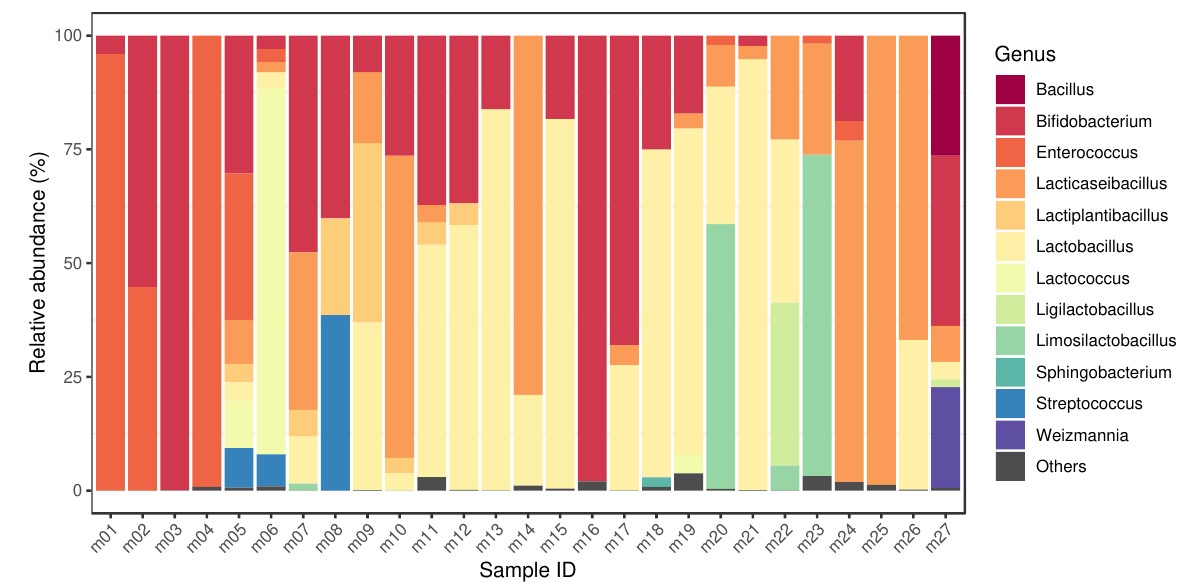
Figure 1. Bacteriome of samples. The relative abundances of genera that achieved more than 1% of the bacterial hits in any of the metagenomic samples. The dominant genera (with mean prevalence) in descending order were Lactobacillus (40%), Enterococcus (35%), Bifidobacterium (34%), Limosilactobacillus (34%), Lactococcus (32%), Lacticaseibacillus (31%), Bacillus (26%), Weizmannia (22%), Ligilactobacillus (19%), Streptococcus (18%), Lactiplantibacillus (12%) and Sphingobacterium (2%). Sample accession numbers for the Sample IDs are listed in Table